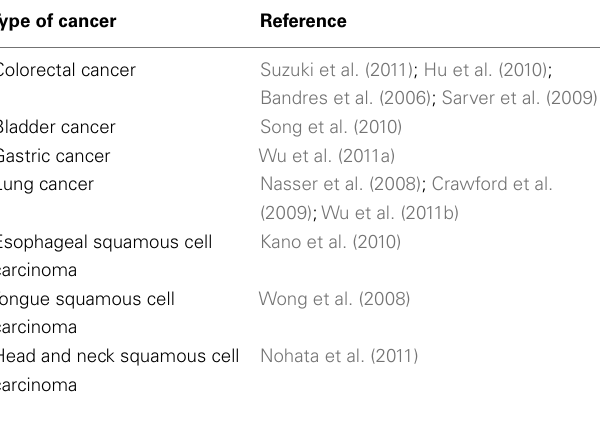
Table 2 | Downregulation of miR-133b in different